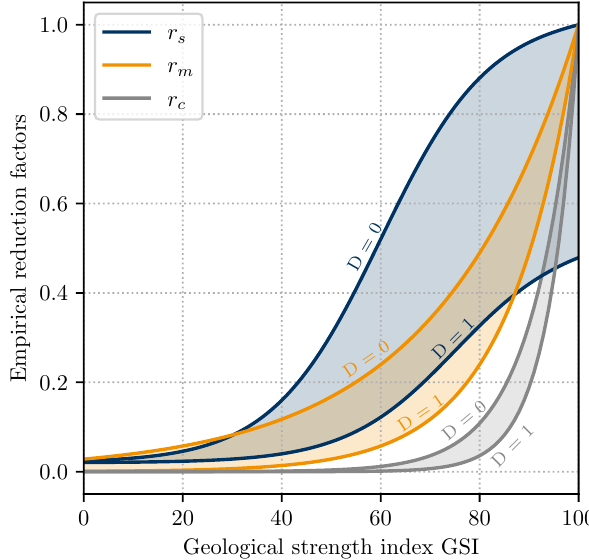
Figure 3. Illustration of the range of the empirical reduction factors r s , r m and r c for the elastic stiffness, the friction parameter and the cohesion parameter, respectively, for 0 ≤ D ≤ 1 in terms of the geological strength index